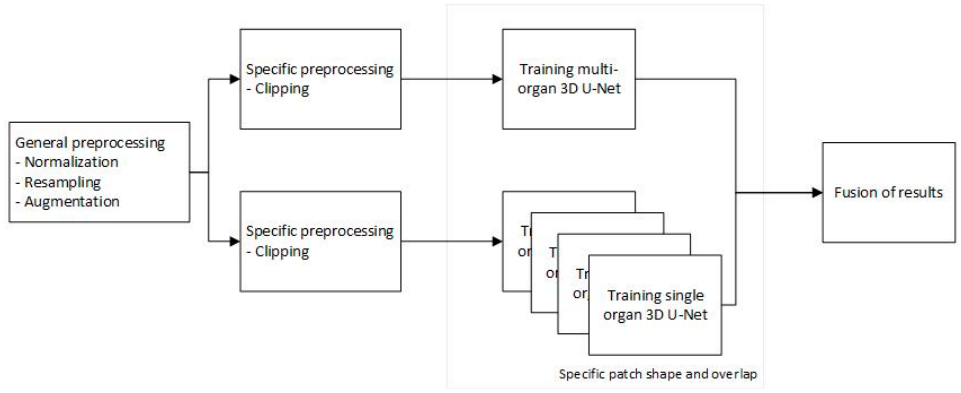
Figure 2. Proposed pipeline. Figure 2. Proposed